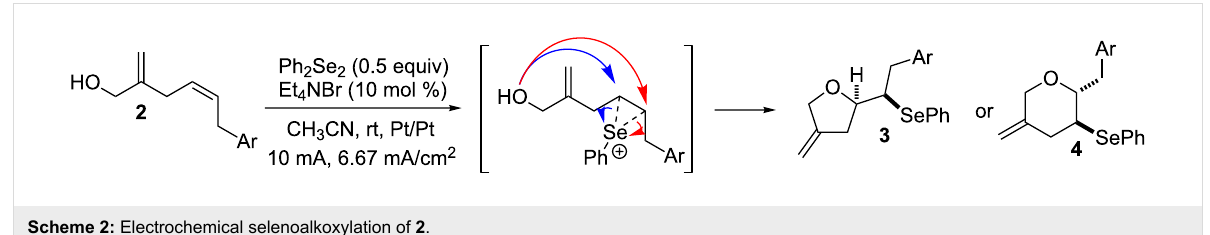
Scheme 2: Electrochemical selenoalkoxylation of 2 .